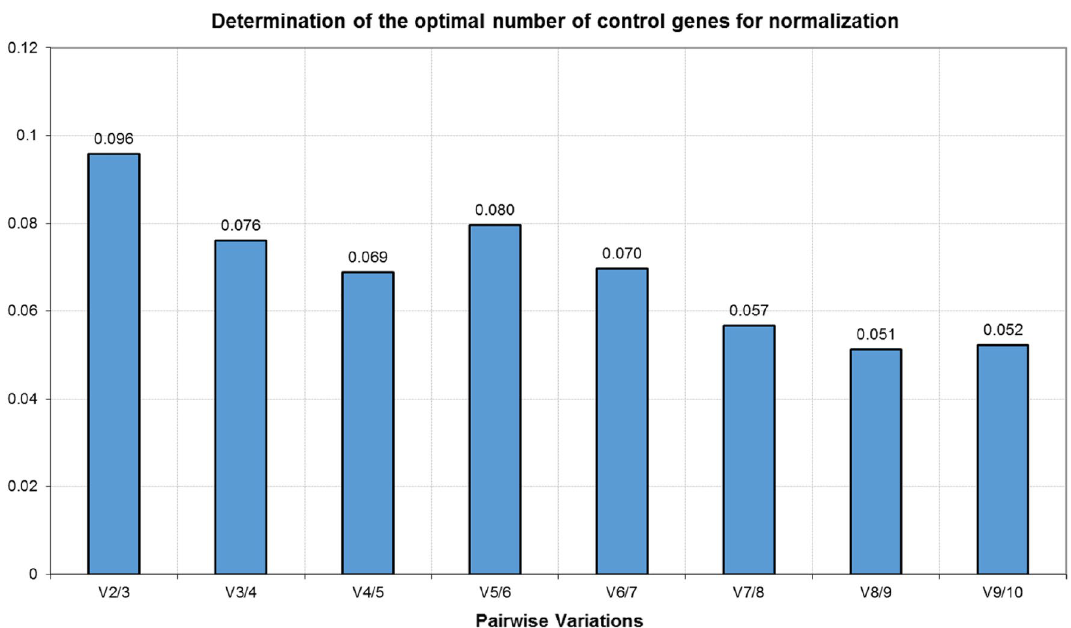
Figure 5. Determination of the optimal number of reference genes calculated by the geNorm algorithm. Pairwise variation (V n /V n + 1 ) lower than 0.15 indicates no significant contribution made by the inclusion of an additional reference